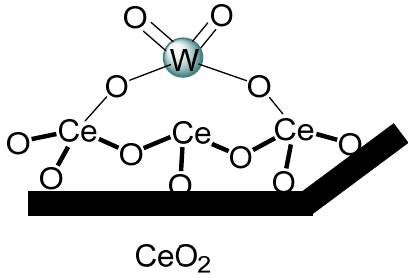
Figure 5. Proposed structure of isolated tungsten bis-oxo on CeO 2 .